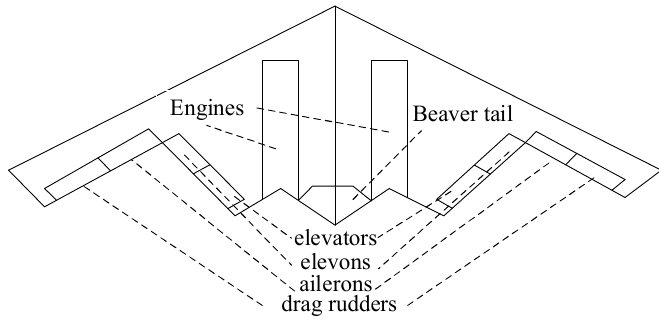
Figure 1. Configuration of flying-wing aircraft.